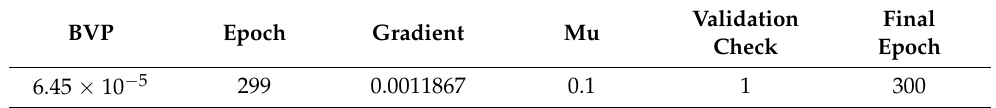
Table 7. Best validation performance and final state parameters. BVP